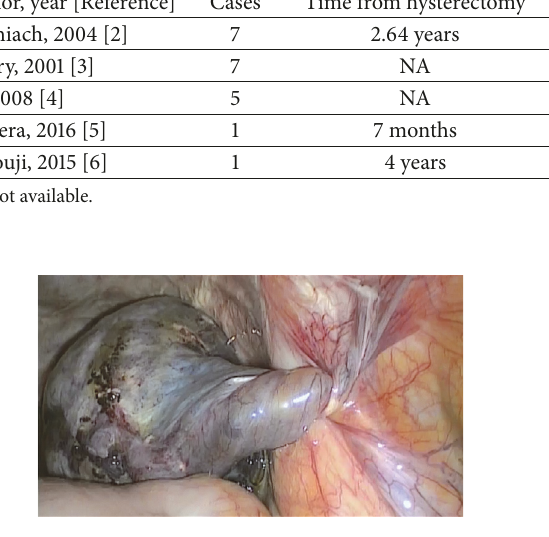
Figure 1: Laparoscopic view of a twisted right ovary. Note the absence of adhesions, which may have facilitated